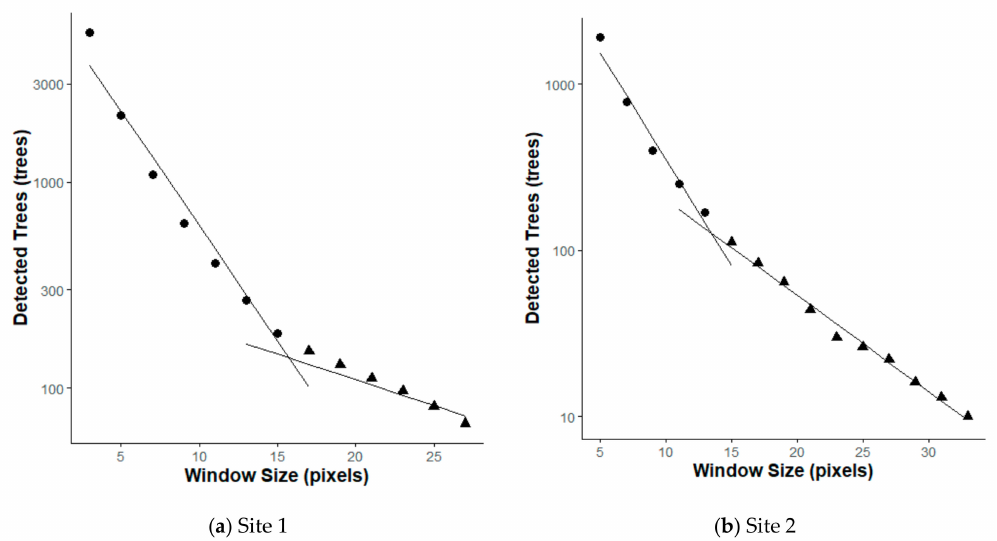
Figure 8. The relationship between the Fixed Window Size (FWS) and the detected trees. The horizontal axis indicating FWS. Plots represent the number of detected treetops by FWS and the plot shapes depends on which segmented regression line the points belong. The elbow points of Site 1 and Site 2 are 15 and 13 pixels, respectively. The equations of segmented lines in both Sites are represented by log 10 ( Detected Trees ) = α × ( Window Size ) + β . In Site 1, left line’s ( α , β ) = ( − 0.11, 3.90) and right line’s ( α , β ) = ( − 0.03, 2.54). In Site 2, left line’s ( α , β ) = ( − 0.13, 3.83) and right line’s ( α , β ) = ( − 0.06,